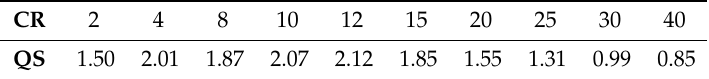
Table 1. Different QS with varying CRs in the CS-base algorithm utilized in the proposed architecture.